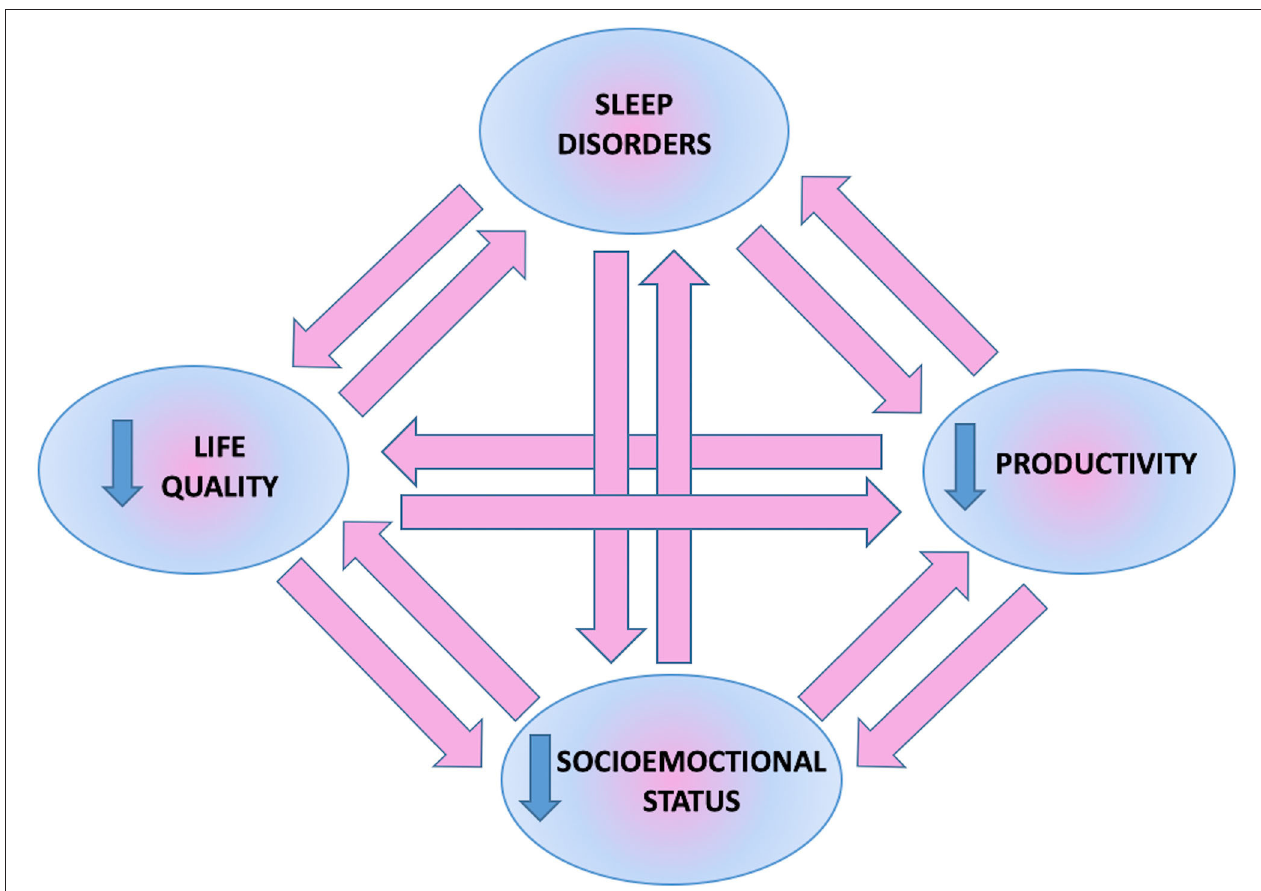
FIGURE 6 | Mutual relationship between sleep disorders, psychoemotional and socioeconomic status of